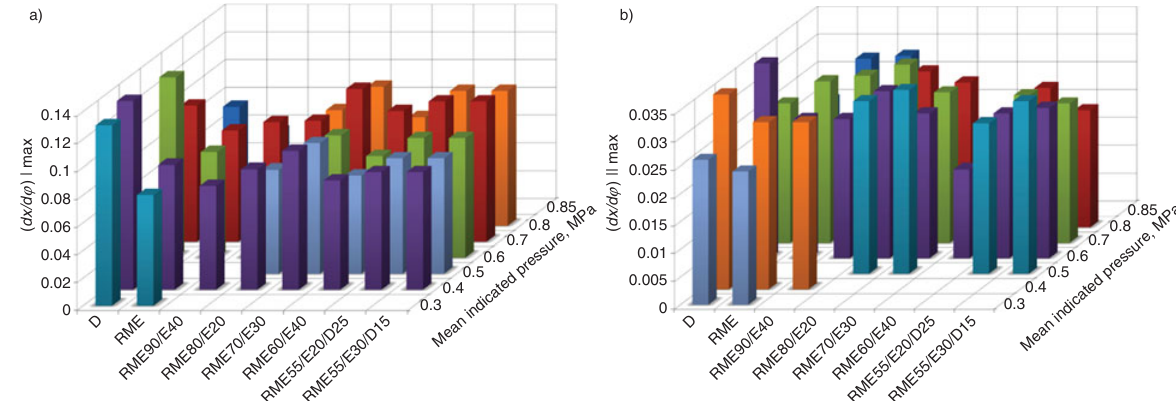
Fig. 1. Indicators of heat release dynamics in 1A41 engine cylinder when running on RME (cid:2) E and D (cid:2) RME (cid:2) E